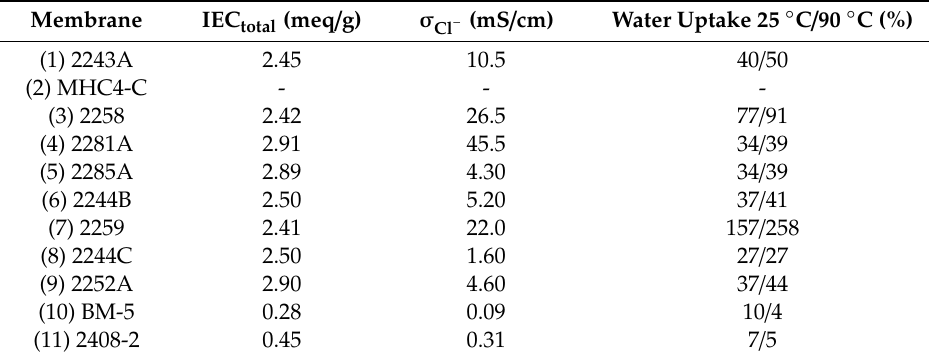
Table 5. IEC total , chloride conductivity, and water uptake of the synthesised AEMs.